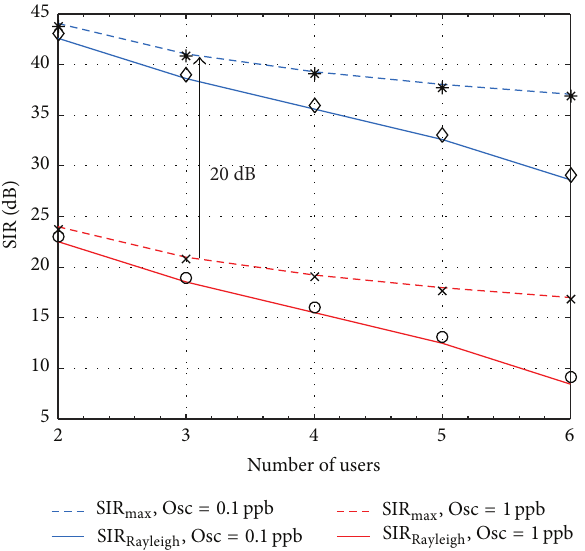
Figure 4: Mean users’ SIR 10ms after most recent precoder update, for the Rayleigh fading and upper bound. Here, 7 base stations serve jointly from 2 to 6 users. Analytical results are shown by lines, simulations by